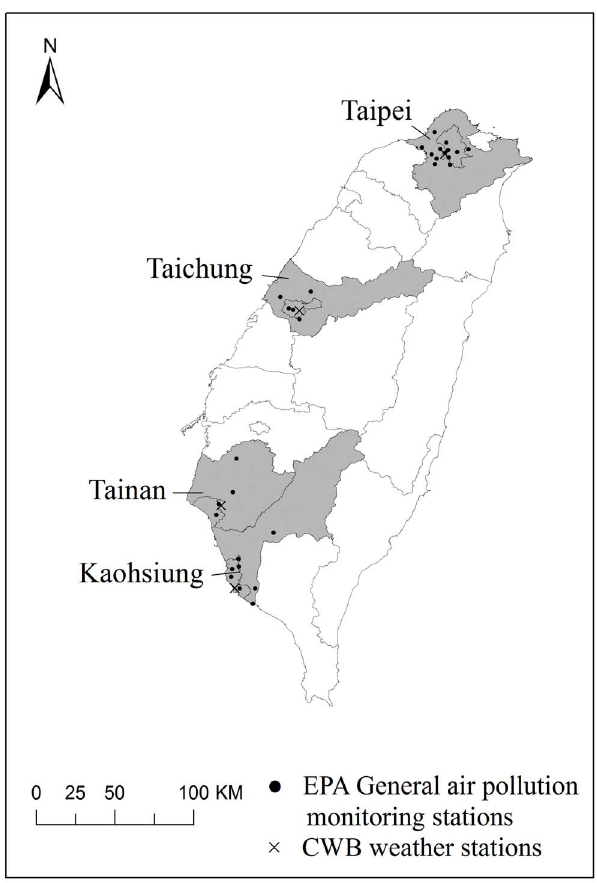
Figure 1. Study area and locations of general air monitoring and surface weather stations in Taiwan during